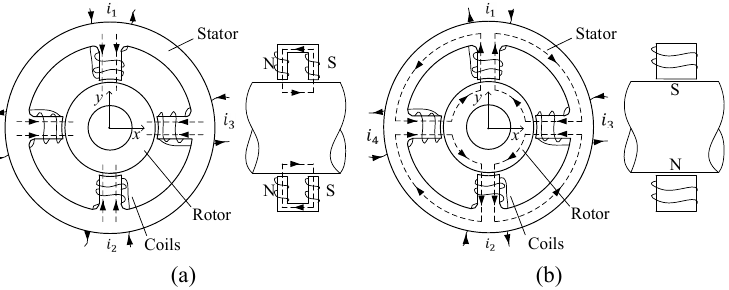
Figure 3. The 4 ‐ pole RMB structure. ( a ) Homopolar structure. ( b ) Heteropolar structure. Figure 3. The 4-pole RMB structure. ( a ) Homopolar structure. ( b ) Heteropolar